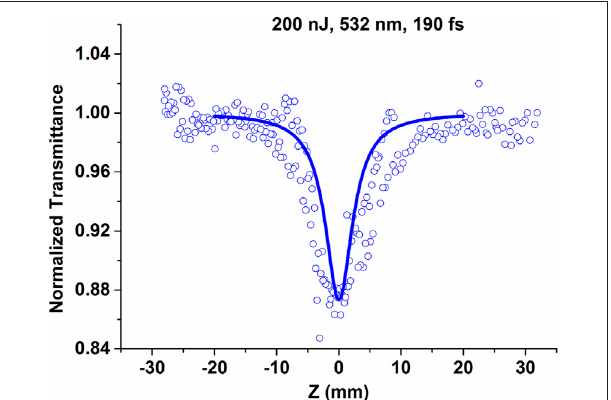
FIGURE 2 | Raman spectrum of the obtained nitrogen-doped diamond crystal.